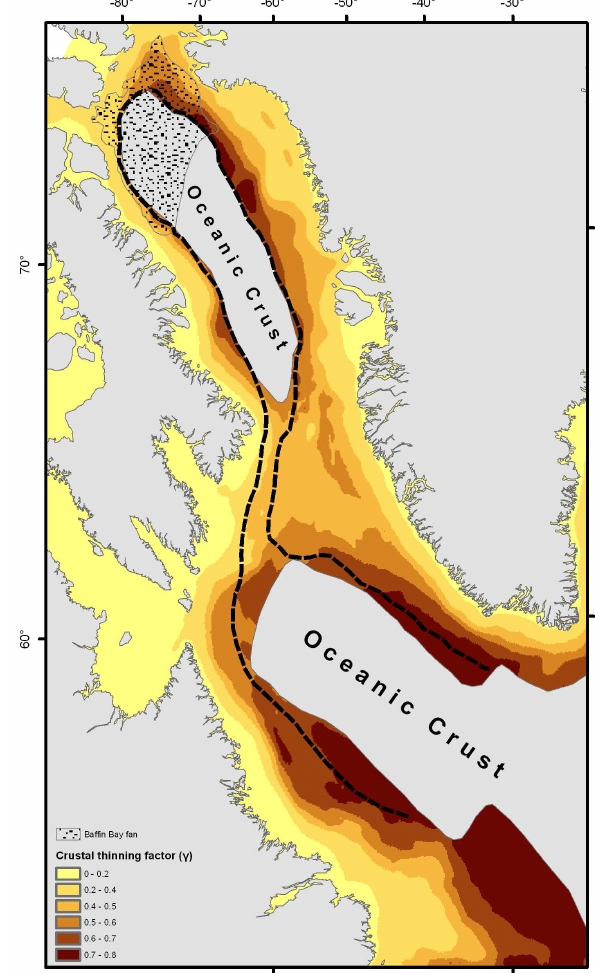
Fig. 10. Crustal thinning factor ( γ ) grid varies between 0 in un- stretched continental crust and more than 0.7, which is the represen- tative of volcanic addition in the form of magmatic underplating or oceanic crust. The thick dashed line is our preferred COB (model 7) that remains approximately at γ =